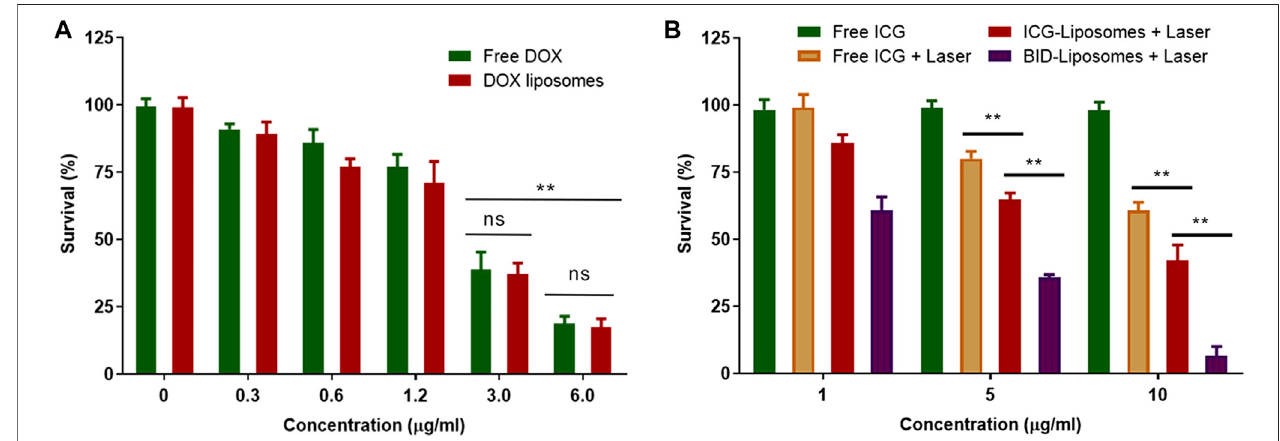
FIGURE 6 | Cytotoxicity assay against 4T1 breast cancer cells. (A) Survival percentage of 4T1 cells under the treatment of various concentrations of free DOX and DOXliposomalnanocomposites. (B) Survivalpercentageof4T1cellsundervarioustreatmentsofchemicalsorcombinedchemo-photo-thermaltreatments(mean ± SD; ** p < 0.01; ns, not signi fi cant; n (cid:1)